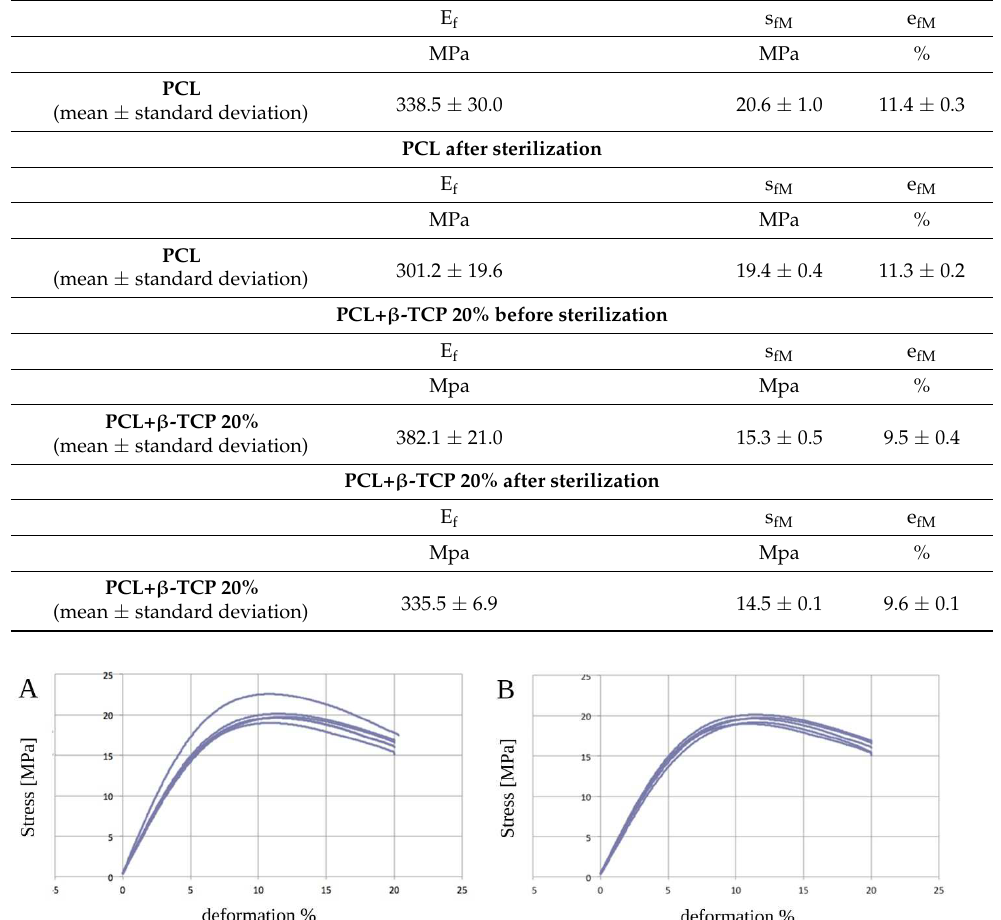
Figure 4. Graphical representations of the five analyses of unsterilised ( A ) and sterilised ( B ) poly(ε-caprolactone) (PCL) samples. No differences in deformation (%) were noticed in the range of observation.